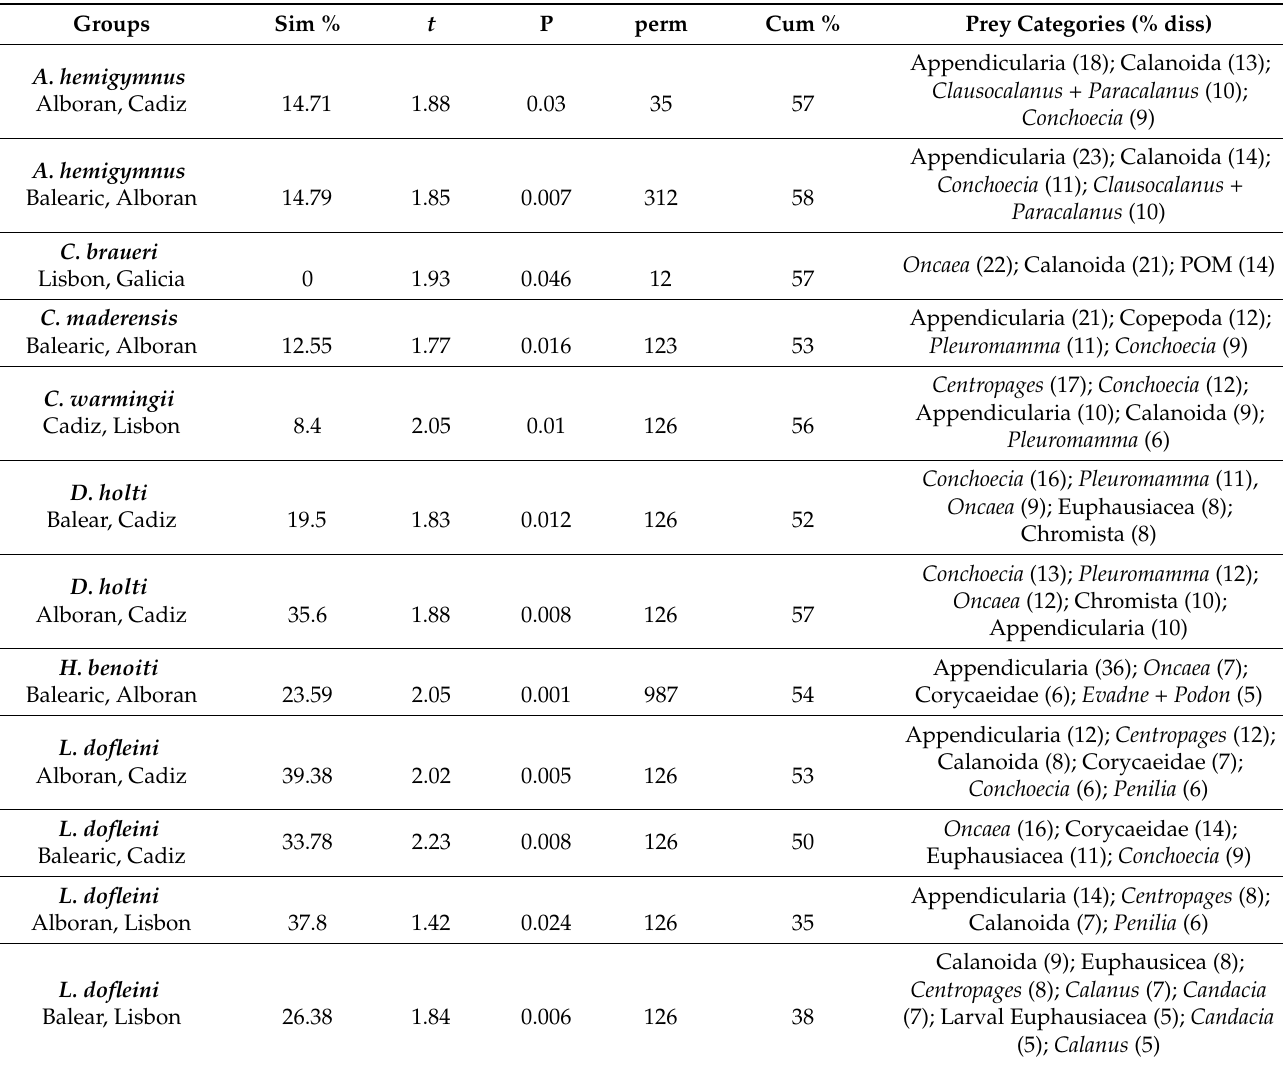
Table 3. PERMANOVA pair-wise tests for mesopelagic fish species between zones (only significant results were listed). Bray–Curtis similarity resemblance. Sum of squares Type III. Unrestricted permutation of raw data (999). Sim %: percentage of average similarity between zones; perm: unique permutations; and cum %: cumulative percentage explained by the variable. Prey categories’ contribution to average dissimilarity percentages (% diss) considering a 90% cut-off (similarity percentage analysis, SIMPER) is shown on the right side of the